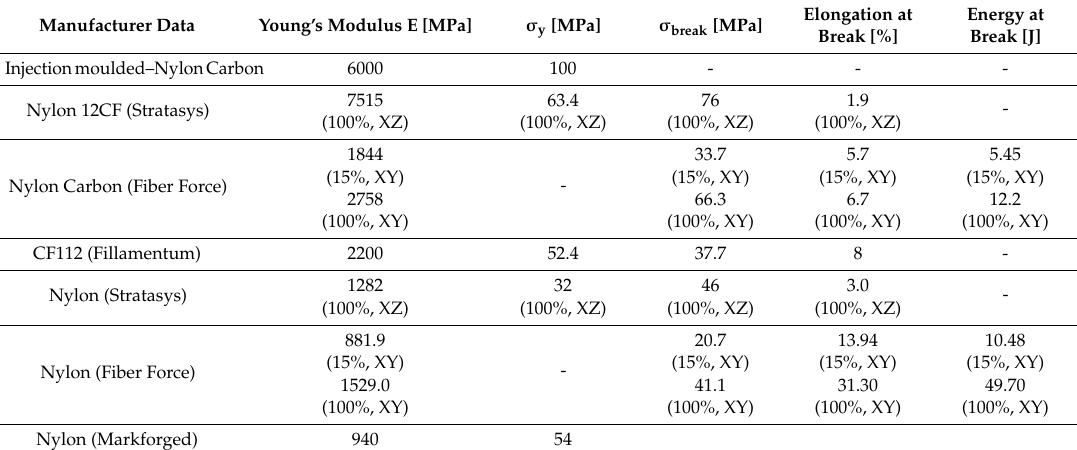
Table 6. Comparison of the tensile test